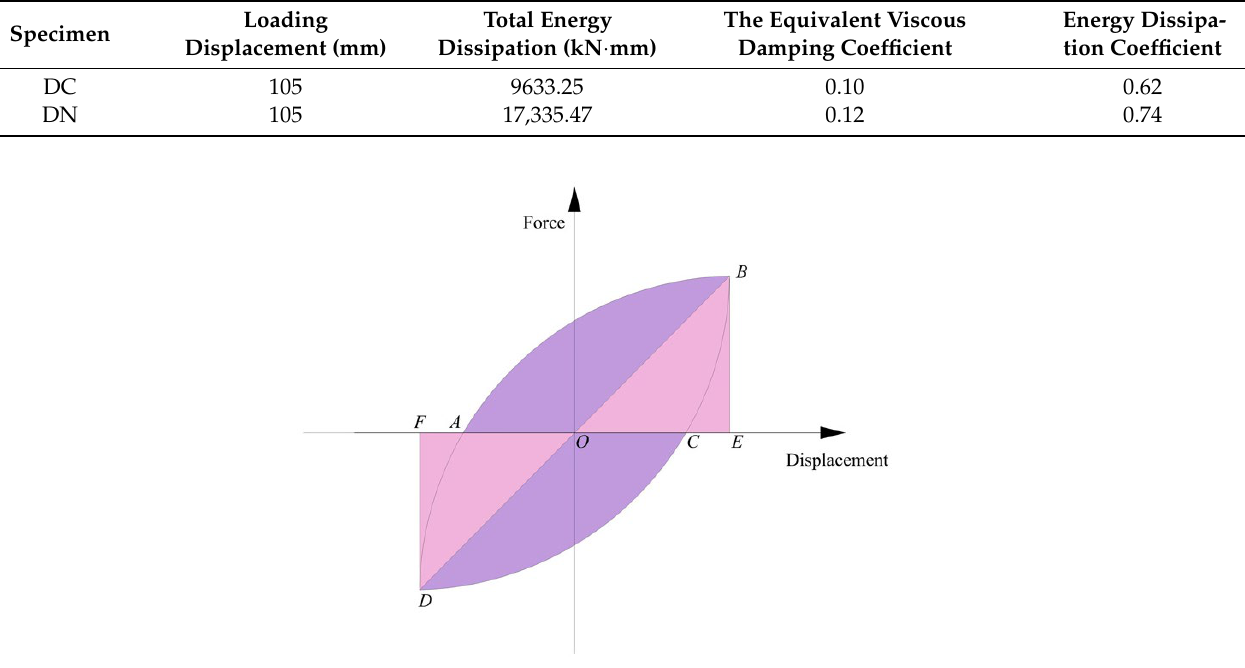
Figure 16. Hysteresis curve.